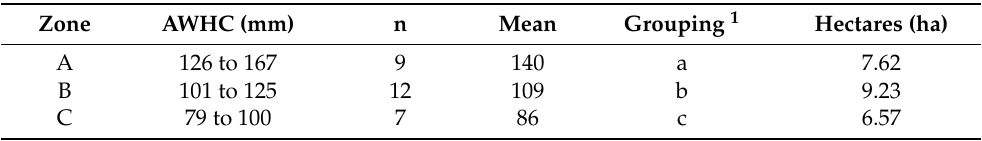
Figure 6. Map of the irrigation management zones in the study site, named zone A, zone B, and zone C. Table 3. Management of zones for the three AWHC categories.